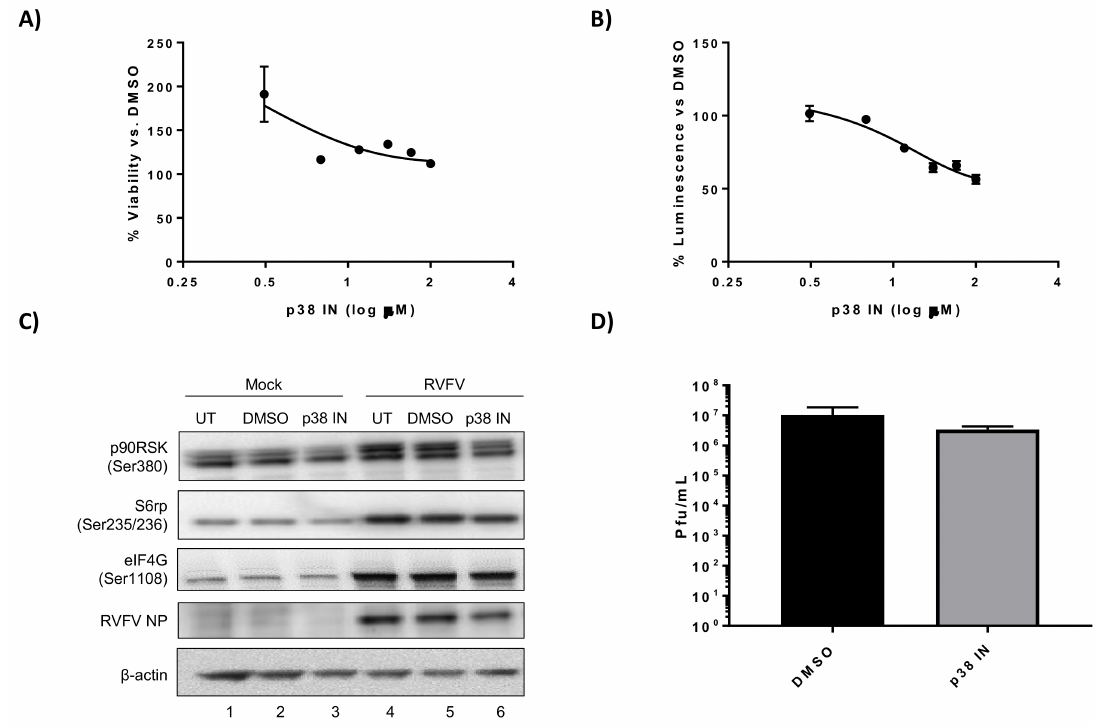
Figure 4. SB203580, a p38 MAPK inhibitor, has a minimal effect on RVFV replication. ( A ) H2.35 cells were treated with SB203580 p38MAPK inhibitor (p38 IN) and cell viability analyzed at 24 h using Cell Titer-Glo. Percent viability was calculated relative to the DMSO control. The mean and SD (N = 3) are plotted; ( B ) H2.35 cells were pre-treated for 1 h, followed by a 1 h infection with RVFV MP12 ∆ NSs-Luc (MOI of 0.1). Cells were analyzed at 18 hpi using the Renilla Glo Assay. Luminescence is presented relative to the DMSO control. The mean and SD (N = 3) are plotted; ( C ) H2.35 cells were serum starved for 72 h and then were pre-treated with either DMSO or 10 µ M p38 IN. Cells were infected with MP12 (MOI 5) for one hour, followed by removal of viral inoculum, and addition of growth medium containing DMSO or 10 µ M p38 IN. At 18 hpi, cell lysates were collected for western blot analysis. UT = untreated. Images are representative of biological replicates; ( D ) H2.35 cells were treated and infected as described in ( C ). At 18 hpi, supernatants were collected for standard plaque assay. The mean and SD (N = 3) are